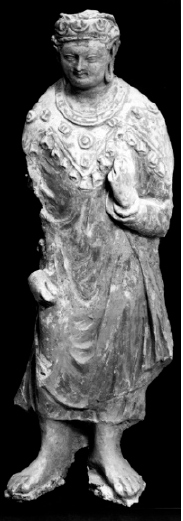
Figure 1. Buddha wearing a crown and jeweled cape, second to fourth c. Gandhara. Stucco. H 51 cm.